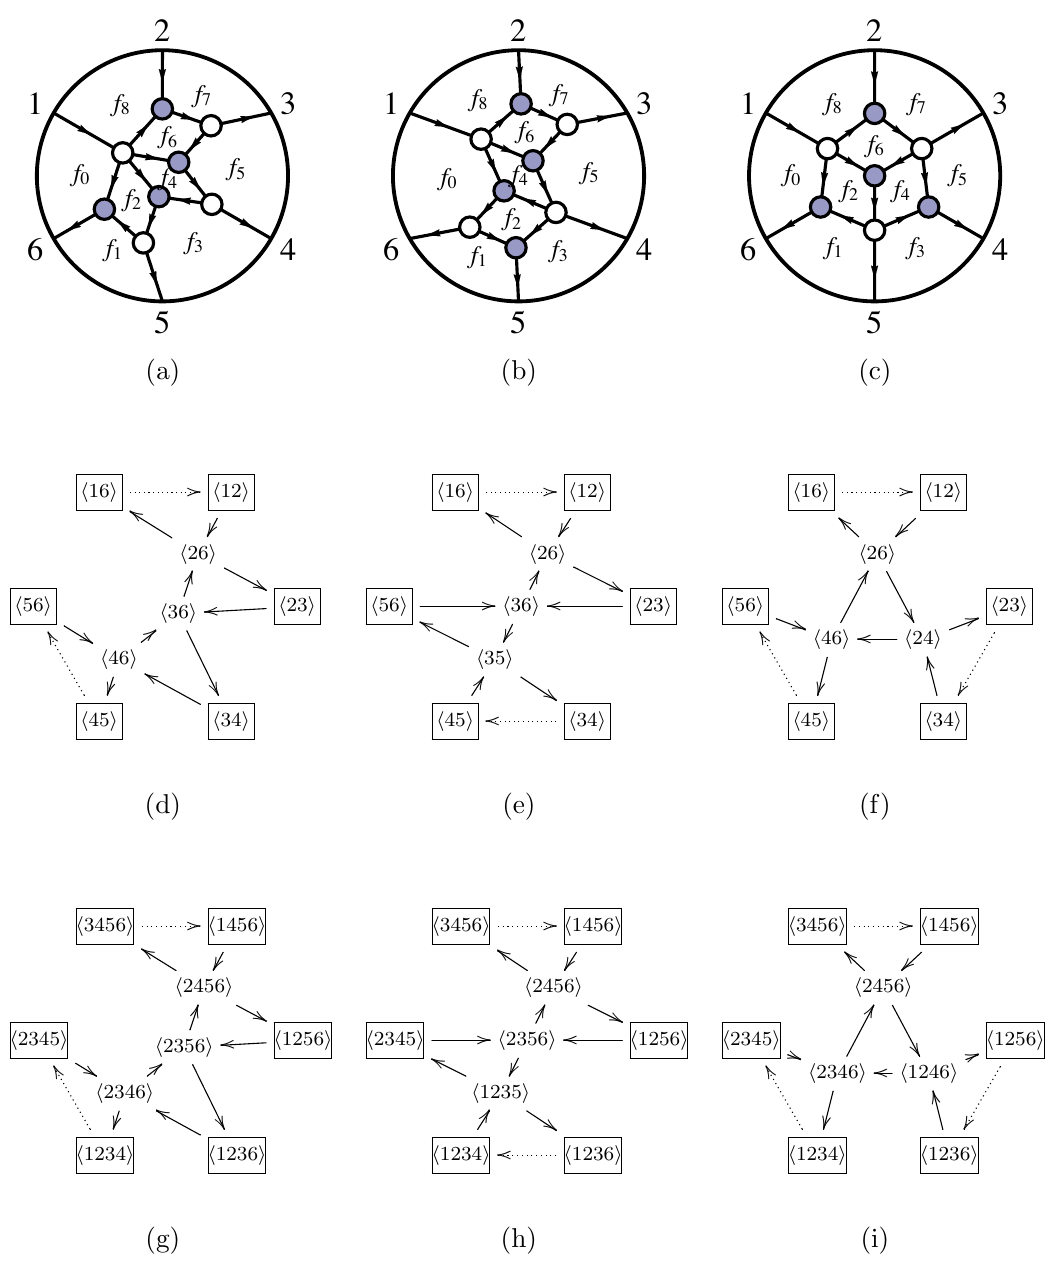
Figure 1 . The three types of (reduced, perfectly orientable, bipartite) plabic graphs corresponding to km -dimensional cells of Gr( k; n ) (cid:21) 0 for k = 2, m = 4 and n = 6 are shown in (a){(c). The associated input and output clusters (see text) are shown in (d){(f) and (g){(i) respectively. Lines connecting two frozen nodes are usually omitted, but we include in (g){(i) the dotted lines (having \black on the right" in the dual plabic graph) that encode (2.6), (A.2) and (A.4) (up to signs).